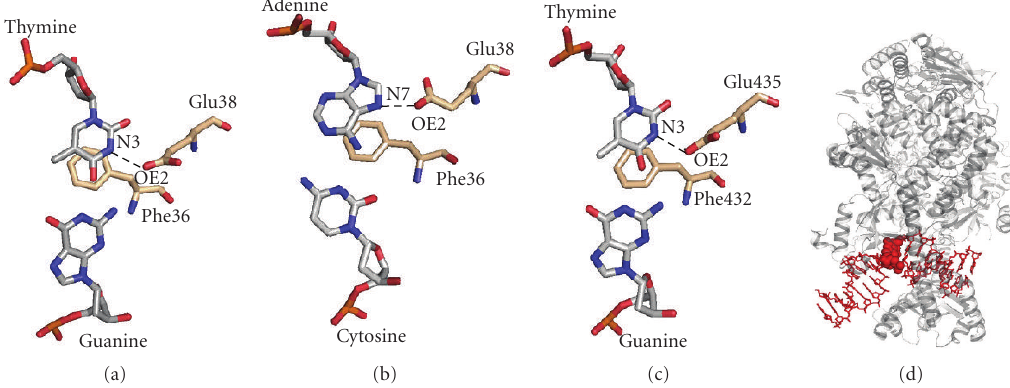
Figure 5: Mismatch recognition mode of MutS. (a) G:T mismatch bound to E. coli MutS (PDB ID: 1E3M). (b) C:A mismatch bound to E. coli MutS (PDB ID: 1OH5). Cytosine residue is in a syn conformation. (c) G:T mismatch bound to human MutS α (PDB ID: 2O8B). (d) Side view of the E. coli MutS-mismatch complex (PDB ID: 1E3M). The mismatched duplex is sharply kinked in the complex with MutS. MutS and mismatched DNA are colored grey and red, respectively. The mismatched G and T are shown in the sphere model.